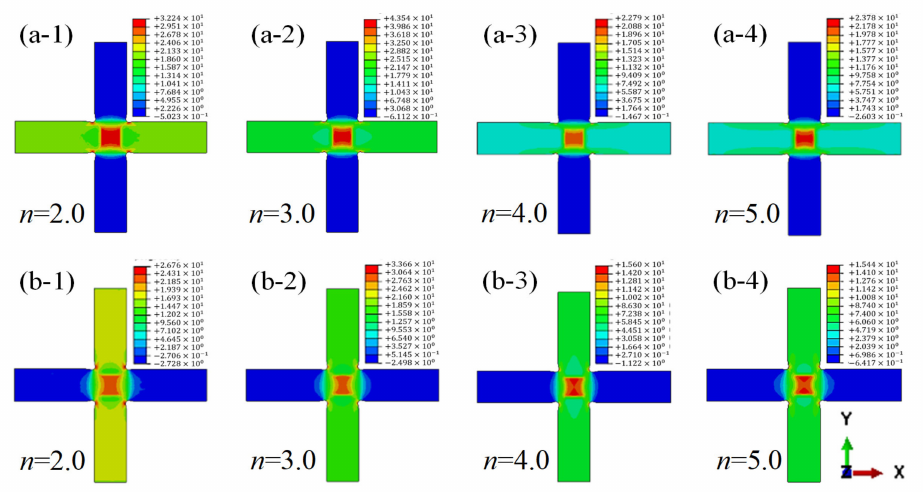
Figure 2. Maximum principal stresses distribution of cruciform specimen ( a ) stresses in 0 ◦ ply when n set as 2.0, 3.0, 4.0, and 5.0. ( b ) Stresses in 90 ◦ ply when n set as 2.0, 3.0, 4.0, and